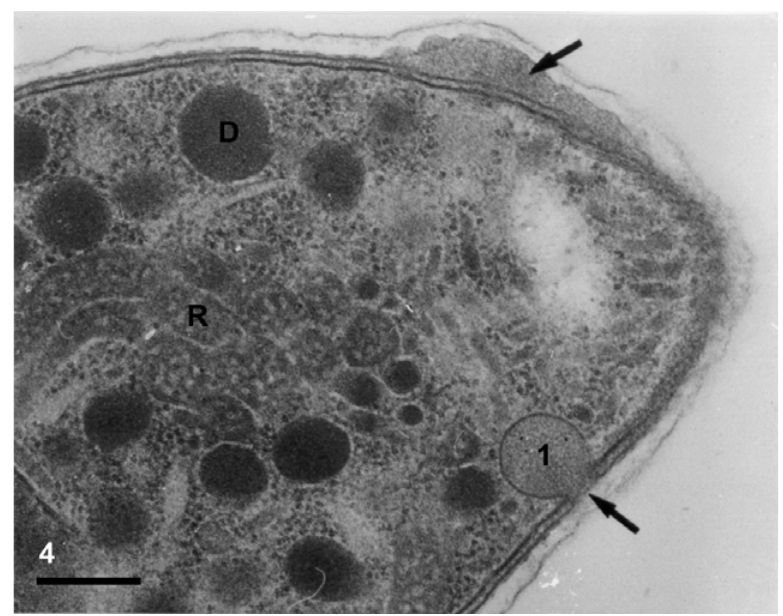
Fig. 4 – Secretion of the dense granule content (arrows) in the lateral side of the tachyzoite form of Toxoplasma gondii . D, dense granules; R, rhoptries. Bar, 0.35 µ m. Courtesy of JF